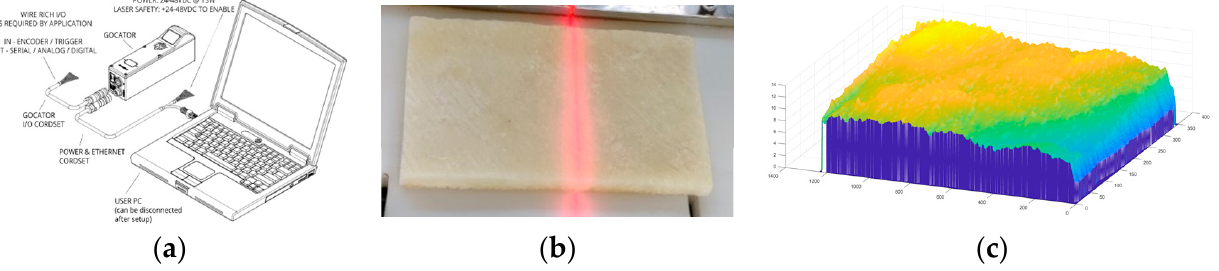
Figure 2. ( a , b ) Fish body scanning process and ( c ) fish body point cloud image.